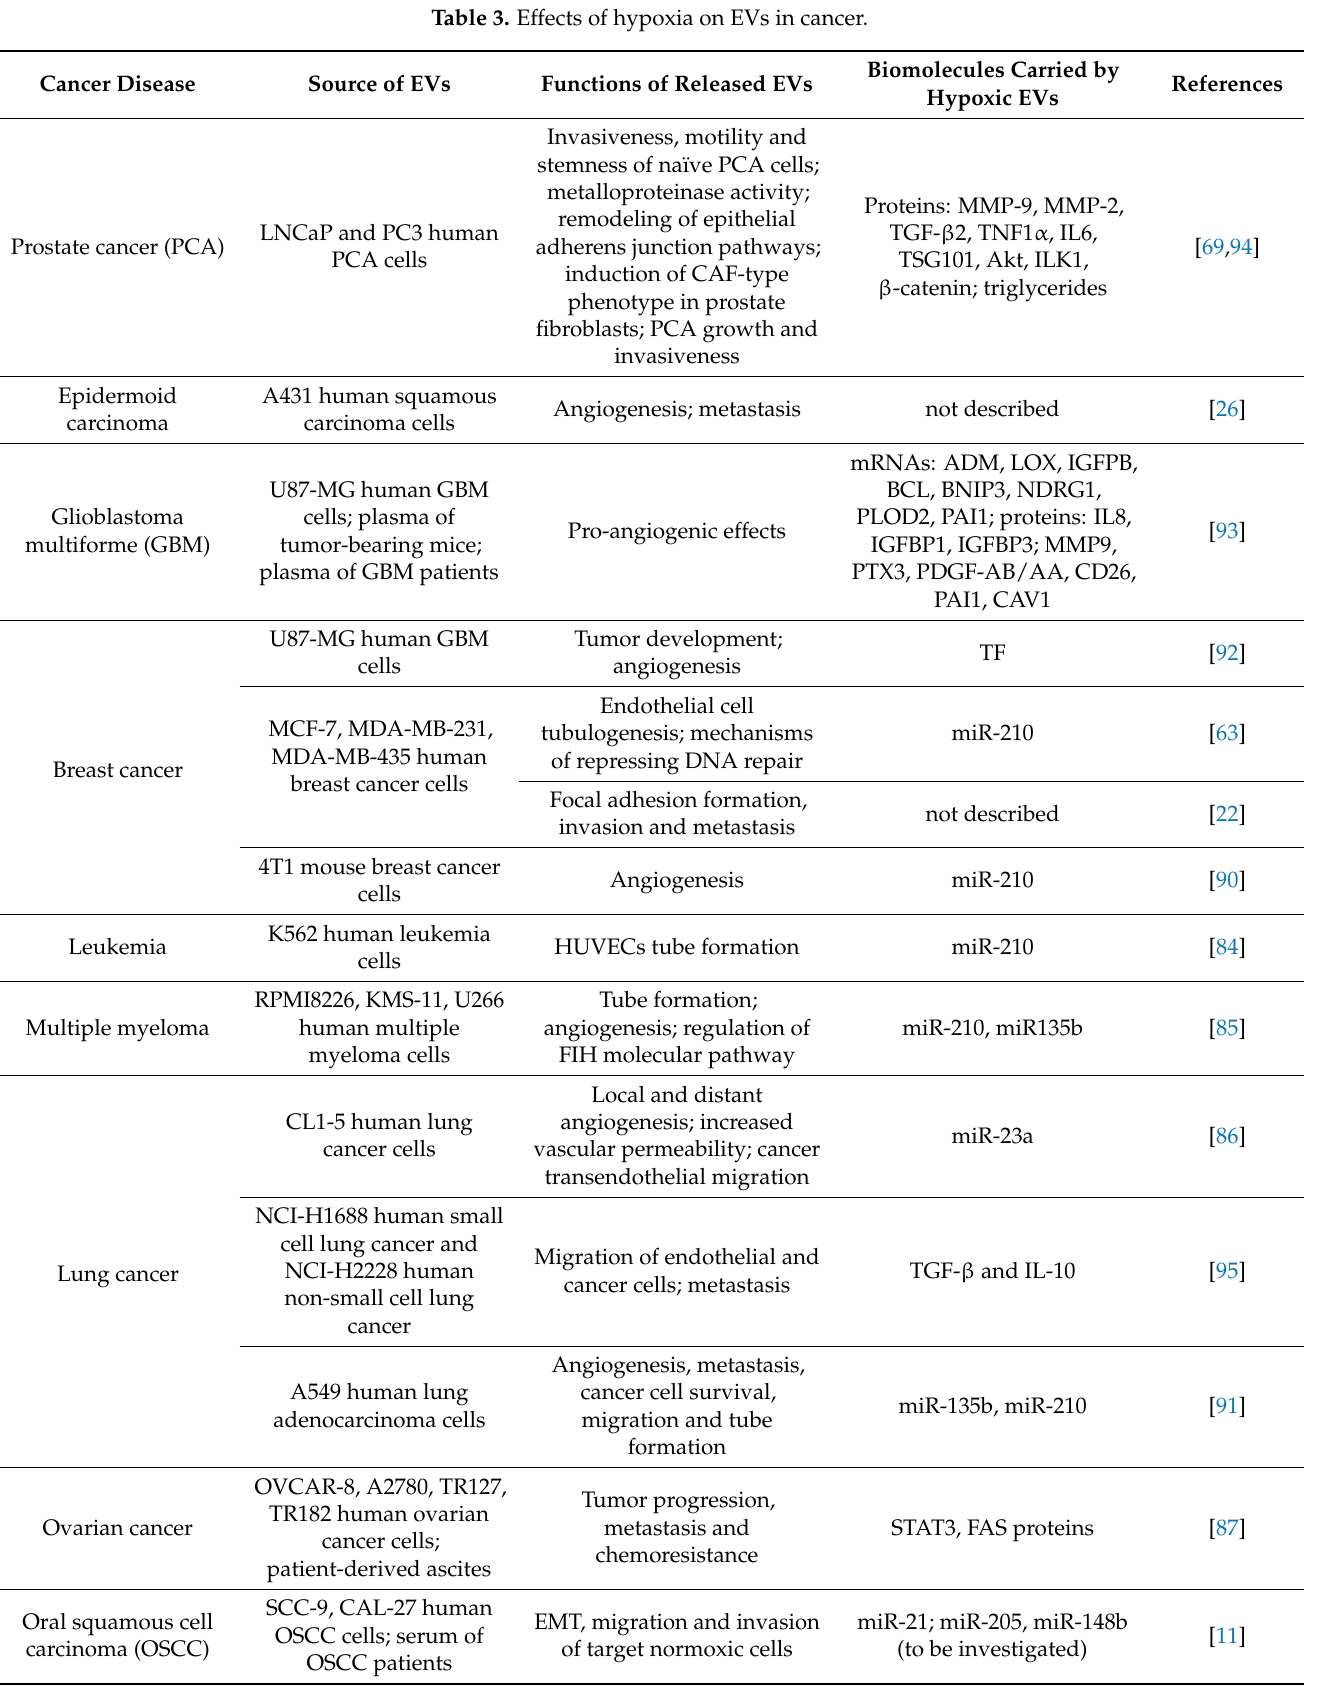
Table 3. Effects of hypoxia on EVs in